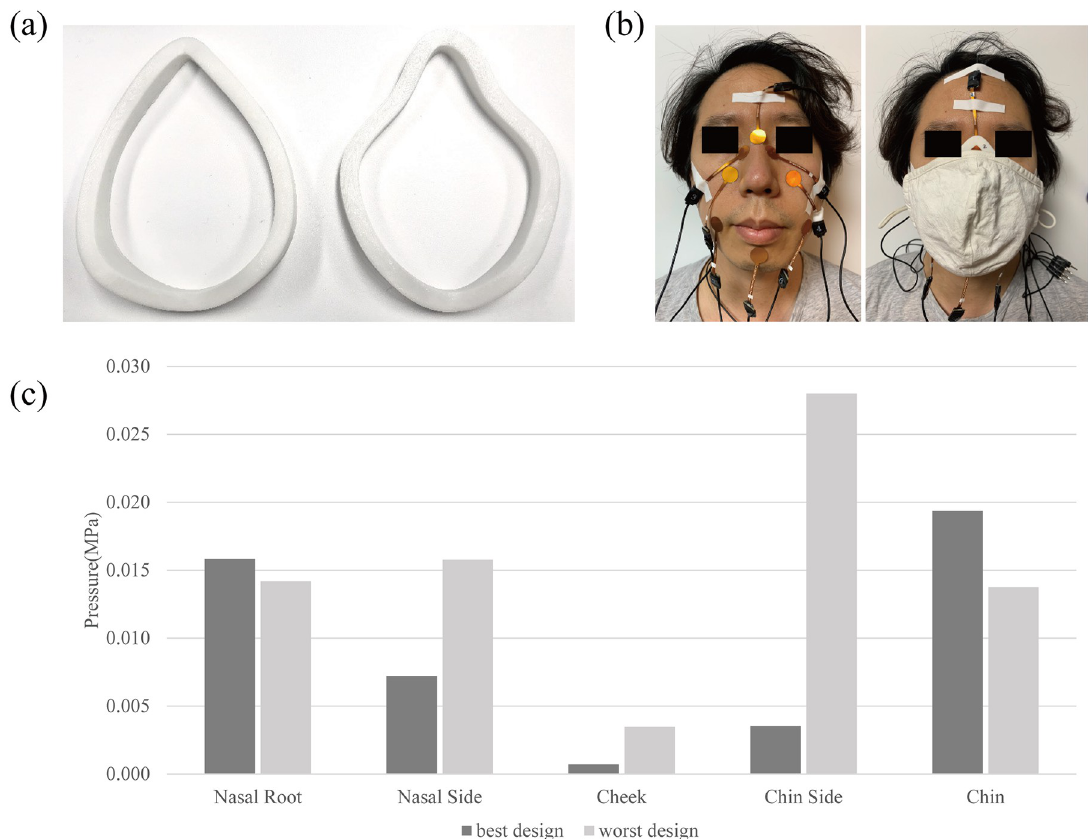
Fig 10. Contact pressure experiment of prototyped mask design and its result. (a) Best design (Left) and worst design (Right). (b) Eight force-sensitive resistor sensor’s location. (c) Contact pressure result of the eight locations.